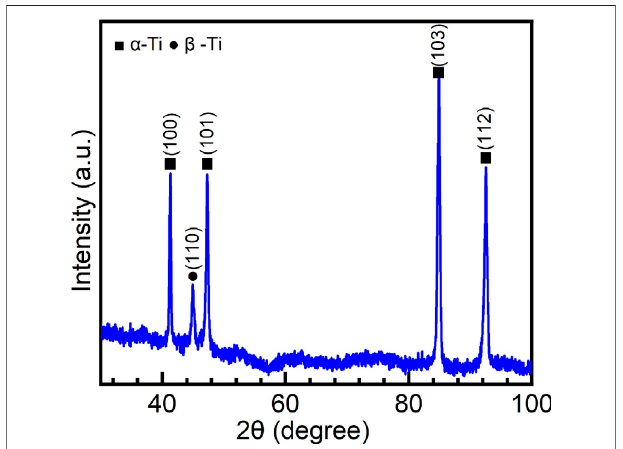
FIGURE 3 | Potentiodynamic polarization curve of as-cast Ti-6Al-4V in Hank ’ s solution at 37 ° C.